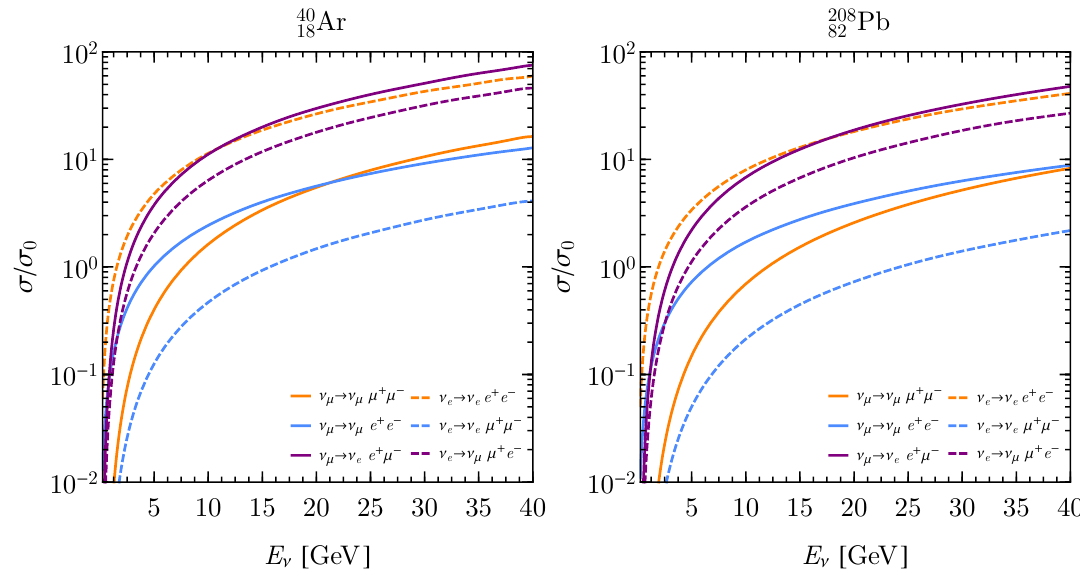
Figure 2 . Cross sections for coherent neutrino trident production on 40 Ar (left) and 208 Pb (right) normalized to (cid:27) 0 = Z 2 10 (cid:0) 44 cm 2 . The full (dashed) lines correspond to the scattering of an